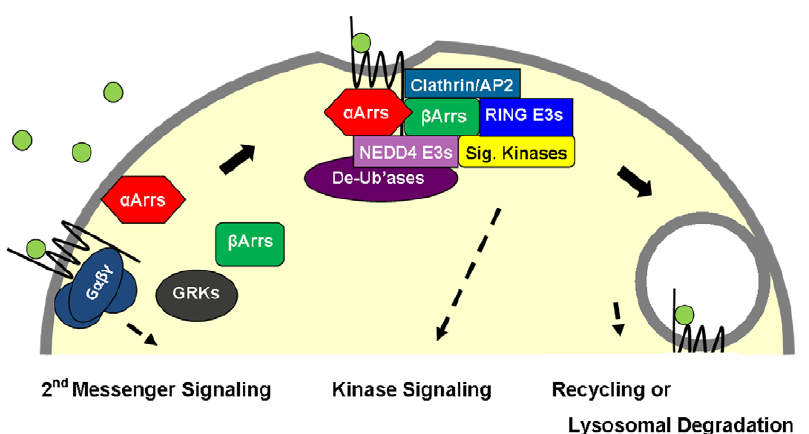
Figure 7. Model of integrated alpha and beta arrestin roles in membrane protein transport in mammals. In the case of 7TMRs, receptor activation results in heterotrimeric G protein signaling through second messenger systems. This is instantly followed by receptor phosphorylation by GRK, which results in beta arrestin binding (arresting further G protein binding/signaling). Our findings suggest that alpha and beta arrestins heteroassociate and have coordinated functions. Among the biological functions that could be regulated by integrated alpha/beta arrestin functions are endocytic trafficking of cell surface cargoes (recycling or lysosomal degradation), kinase signaling (e.g., metabolism, cell growth, survival/ apoptosis) and cytoskeletal dynamics. Alpha and beta arrestins could have a yin yang relationship with both antagonistic (e.g., inactivating and activating, respectively) and cooperative properties depending on context. We envision that arrestins are dynamic adaptors that can integrate internal and external information to mediate programmed ends (i.e., programs created through evolutionary processes). This is largely achieved through reversible posttranslational modifications, such as phosphorylation (not shown) and ubiqutination, and their effects on protein-protein